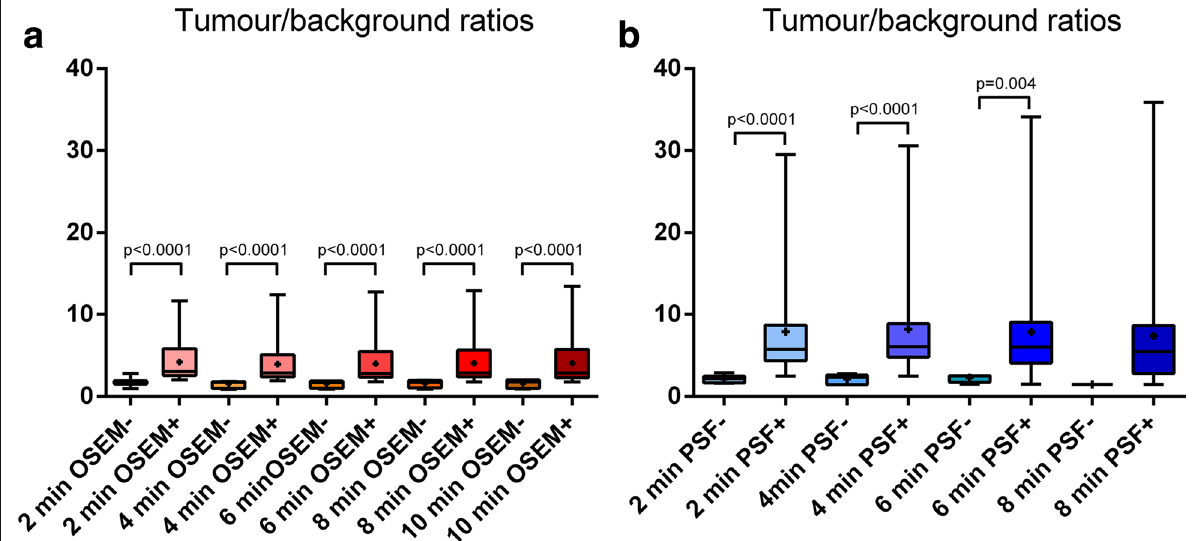
Fig. 3 Comparison of the tumour/background ratios (TBRs) from 2 to 10 min between 18 FDG-foci evidenced (+) or not ( − ) in 3D-OSEM-reconstructed ( a ) and PSF allpass -reconstructed ( b ) head-and-neck PET data sets. The comparison was not performed at 8 min for PSF allpass -reconstructed images because of the number of values in the PSF − group ( n